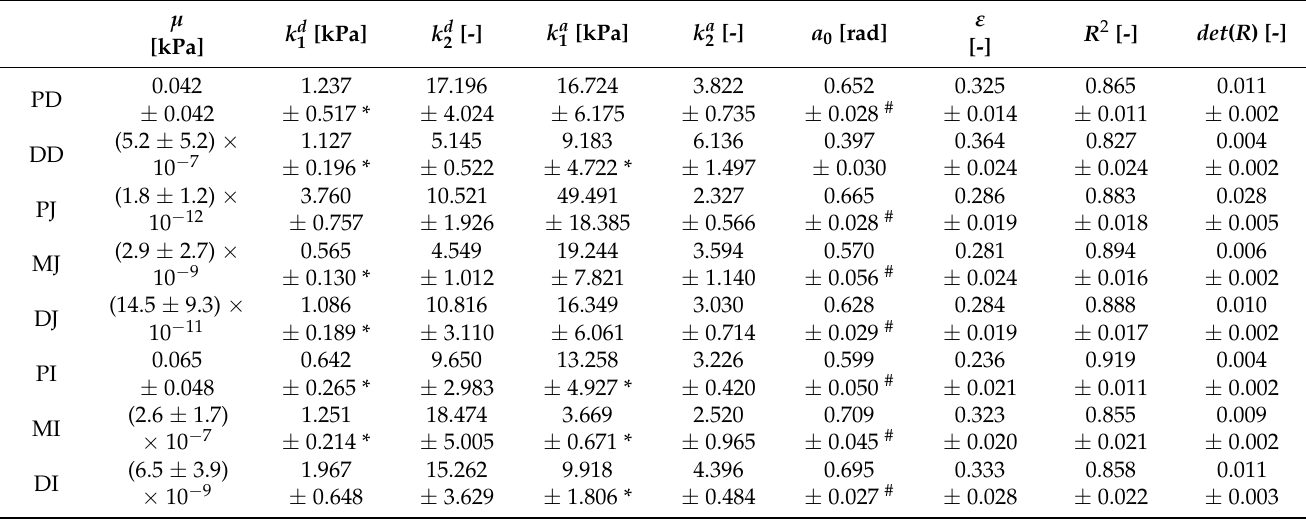
Figure 8. As Figure 4 but using the neo-Hookean and (diagonal and axial)-fiber family model with the following best-fit model parameters for the ( a ) proximal ileum: 𝜇 = 0.102 kPa, 𝑘 1 𝑑 = 0.006 kPa, 𝑘 2𝑑 = 6.310, 𝑘 1𝑎 = 1.965 kPa, 𝑘 2𝑎 = 2.102, 𝑎 0 = 0.513 rad, ε = 0.260, R 2 = 0.905, det ( R ) = 4.8 × 10 − 4 , ( b ) middle ileum: 𝜇 = 3.2 × 10 −11 kPa, 𝑘 1𝑑 = 0.694 kPa, 𝑘 2𝑑 = 4.890, 𝑘 1𝑎 = 3.722 kPa, 𝑘 2𝑎 = 7.5 × 10 −11 , 𝑎 0 = 0.852 rad, ε = 0.380, 𝑅 2 = 0.788, 𝑑𝑒𝑡(𝐑) = 0.002, and ( c ) distal ileum: 𝜇 = 6.3 × 10 −14 kPa, 𝑘 1𝑑 = 3.281 kPa, 𝑘 2𝑑 = 29.283, 𝑘 1𝑎 = 7.588 kPa, 𝑘 2𝑎 = 4.554, 𝑎 0 = 0.678 rad, ε = 0.378, 𝑅 2 = 0.825, 𝑑𝑒𝑡(𝐑) = 0.016. Data are shown every 0.5 mmHg for clarity. Table 3. Parameters of the neo-Hookean and (diagonal and axial)-fiber family model fitted to experimental data of eight small intestinal segments. 𝒌 𝟏𝒅 𝒌 𝟐𝒅 μ [kPa] [kPa]